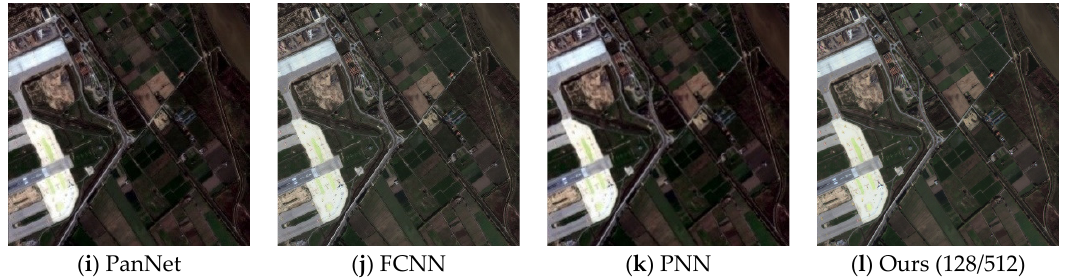
Figure 9. Fusion results for the first group of remote sensing image data.